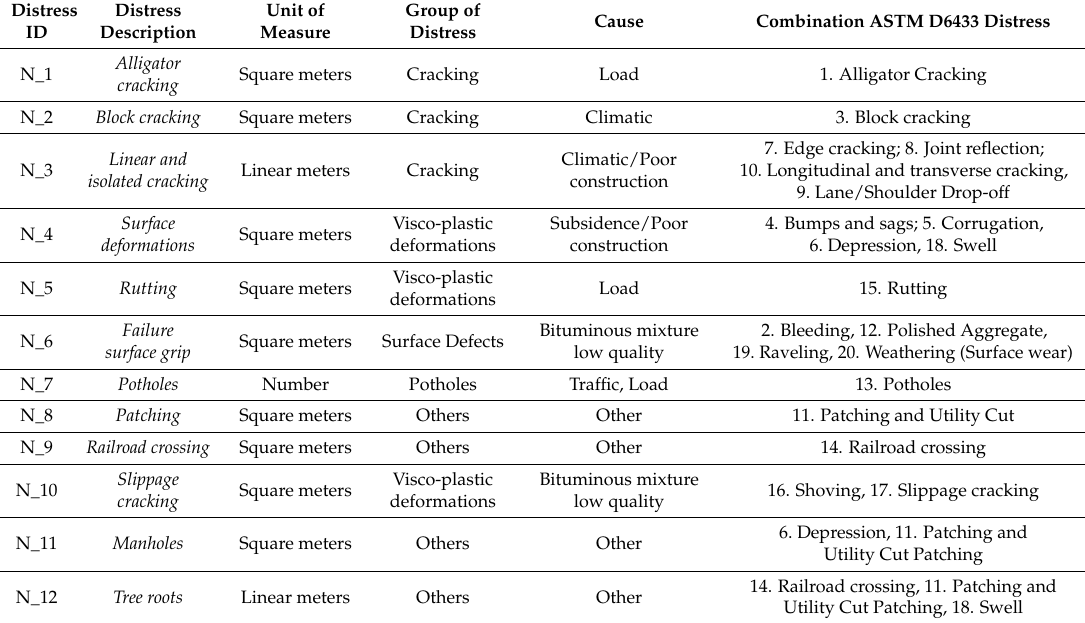
Table 4. New distress identification catalogue asphalt concrete pavement for urban